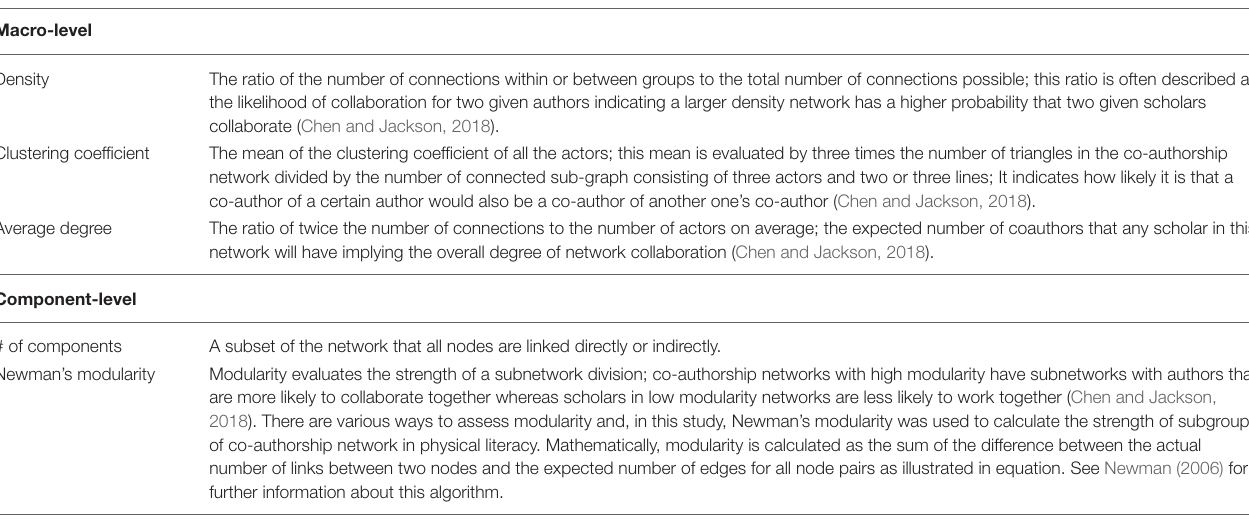
TABLE 1 | Definitions of network